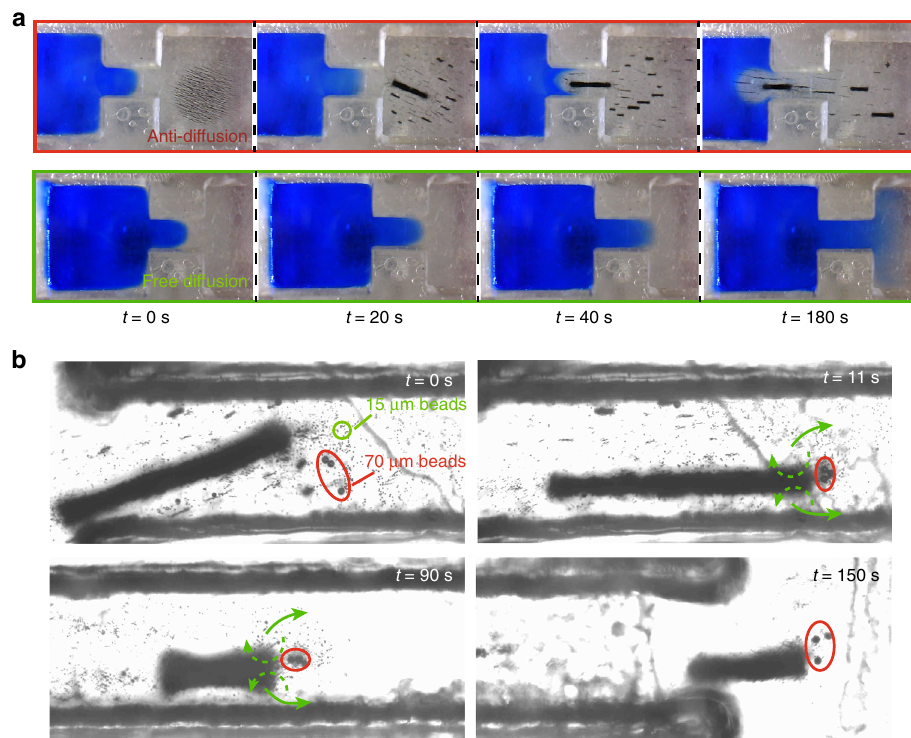
Fig. 5 Anti-diffusion and sorting of non-magnetic beads using the microswarm. a The anti-diffusion effect induced by a ribbon-like microswarm in a microchannel. b Sorting 70 μ m-diameter beads out from 15 μ m-diameter beads in a channel using the microswarm. The 70 μ m-diameter beads are labelled in the red ellipses, while some of the 15 μ m-diameter beads are labelled in the green ellipse. One part of the small beads are pushed aside by the fl ow generated at the tip of the microswarm, as shown by the green arrows. The other part of the small beads are fi rst attracted into the swarm, and then they are pumped out at some locations near the swarm tip, as shown by the green dotted